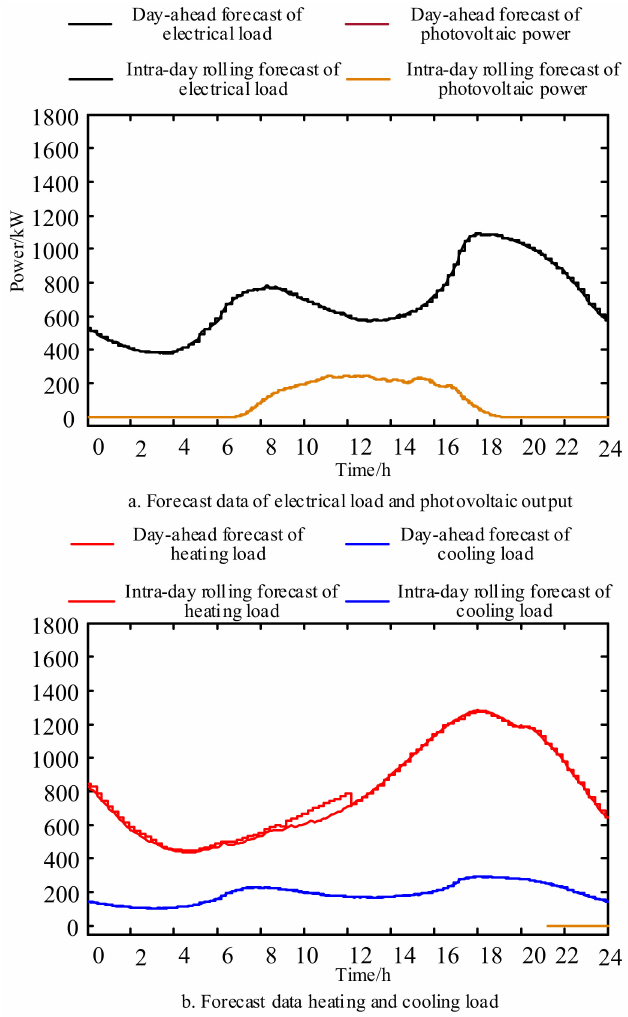
Figure A1. The day-ahead and intra- day forecast curves of PV and load output of the energy station 2.